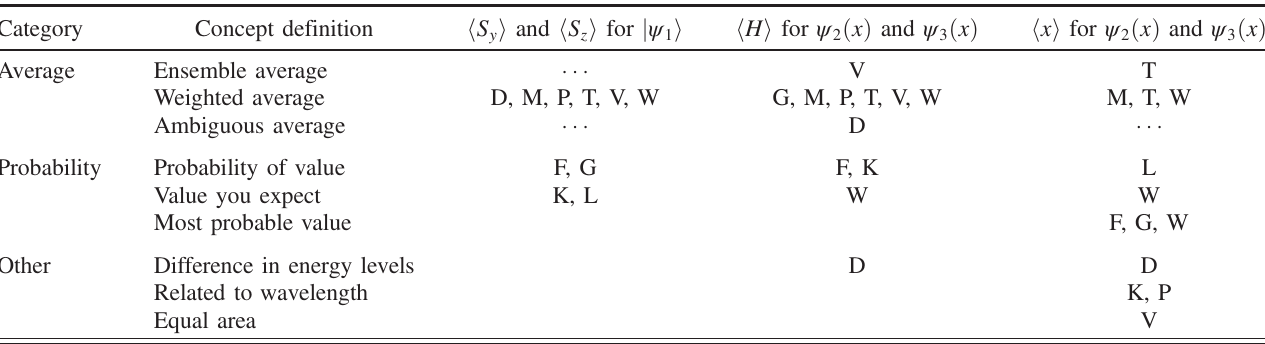
TABLE III. Concept definitions identified in the responses of the 10 students that were interviewed in both the spin and wave function contexts. Students are identified by the first letter of their pseudonym. A blank entry implies that the concept definition did not appear for any of the interviewed students. A “ (cid:3) (cid:3) (cid:3) ” implies the concept definition was present for some students, but not for the 10 students analyzed in this section. Note that some student responses were found to have multiple concept definitions within a single question.